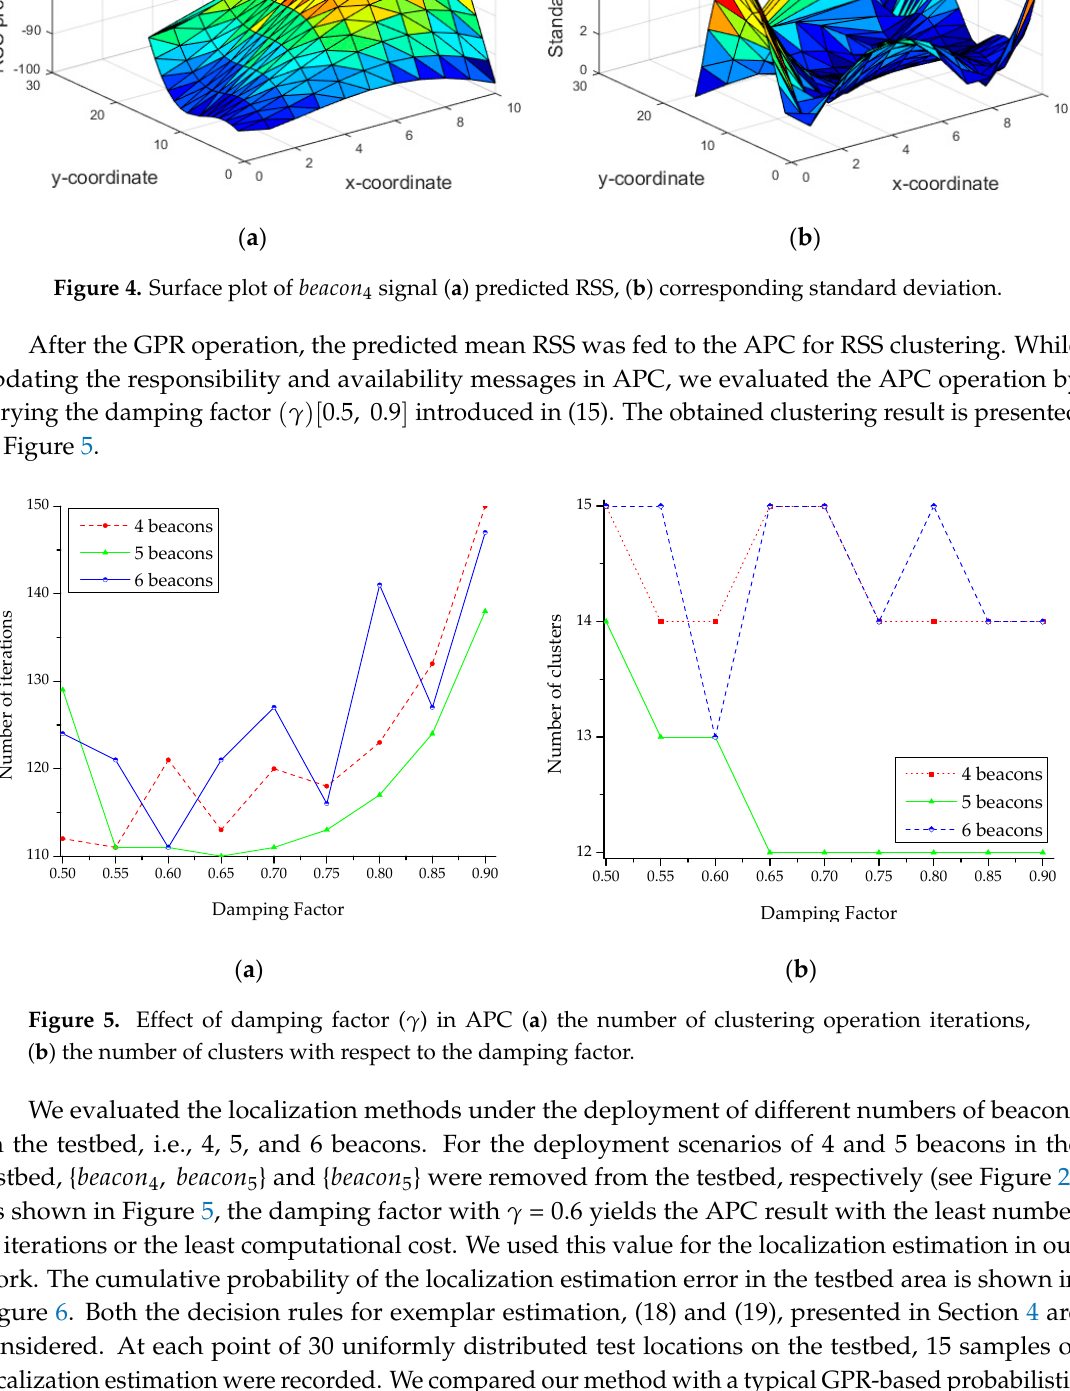
Figure 3. Estimation of 𝑏𝑒𝑎𝑐𝑜𝑛 (cid:2872) signal with GPR ( a ) predicted RSS, ( b ) the corresponding standard deviation at the measurement locations.